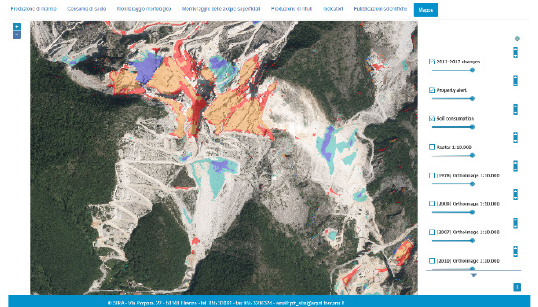
Figure 6 . 2D web interface. Active layers: (a) background: 2017 BW orthoimage (b) foreground: 3D changes between 2017 and 2012.